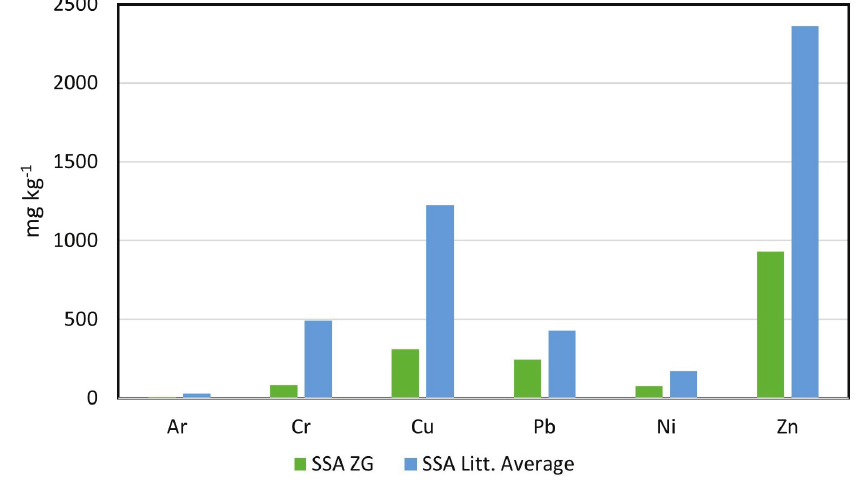
Fig. 4 – Comparison of heavy metals from SSA Zagreb with experimental data from the literature